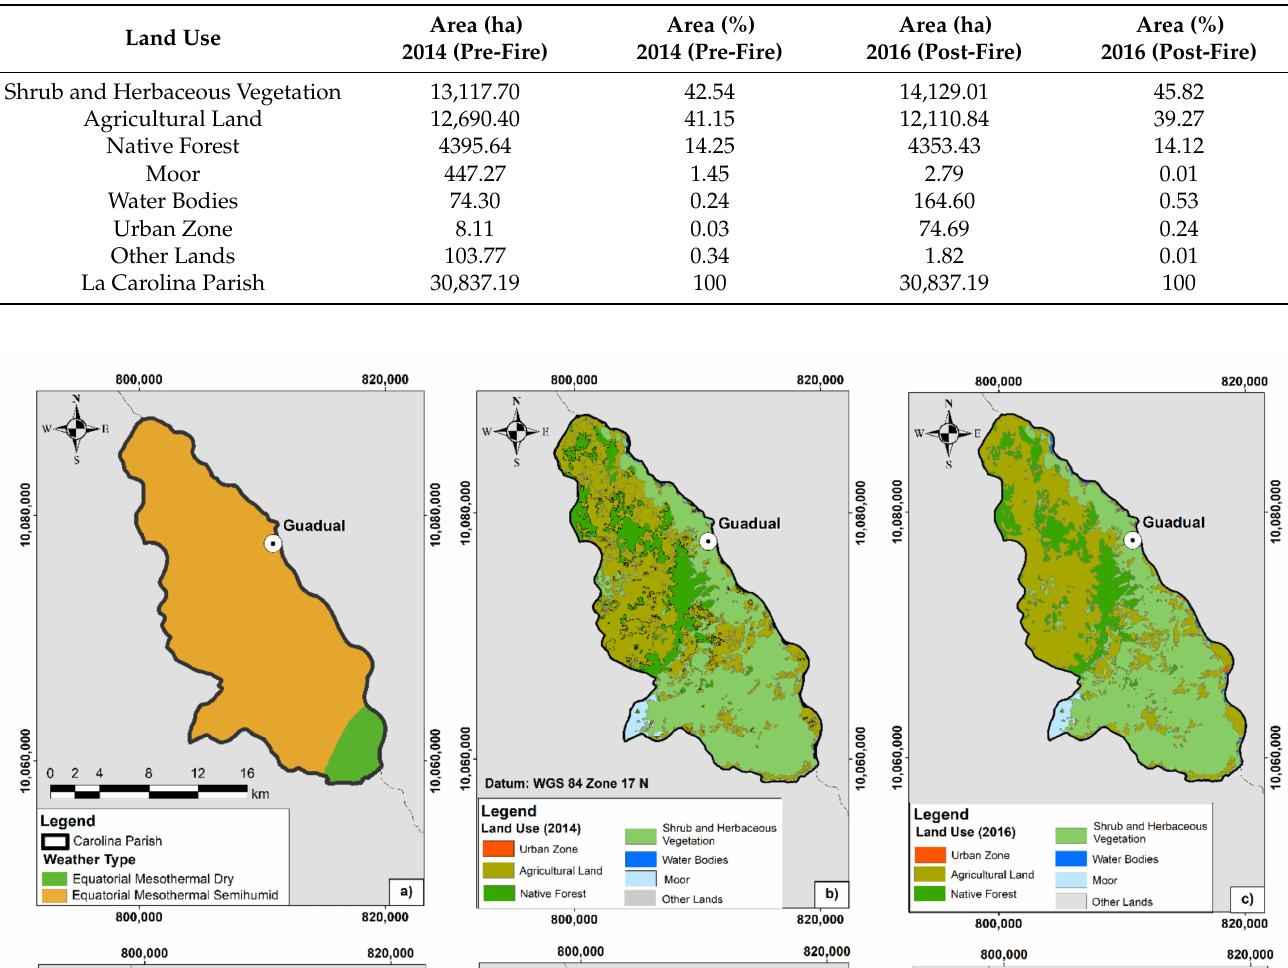
Table 2. Pre-fire and post-fire land use areas in La Carolina parish. Source: adapted from [77].